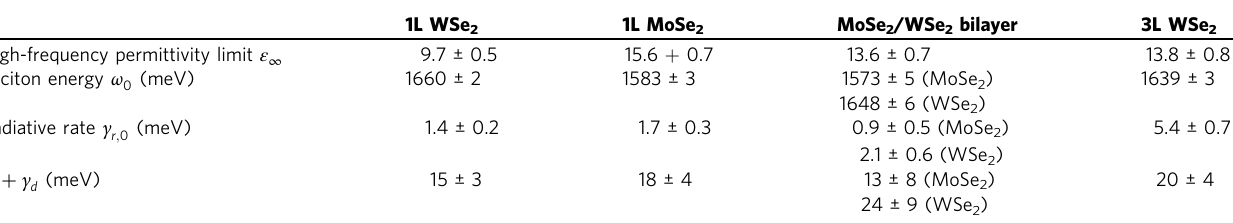
Table 1 The parameters of Lorentz model used to describe TMD dielectric function as obtained from fi tting s-SNOM spectra with the point dipole model. 1L WSe 2